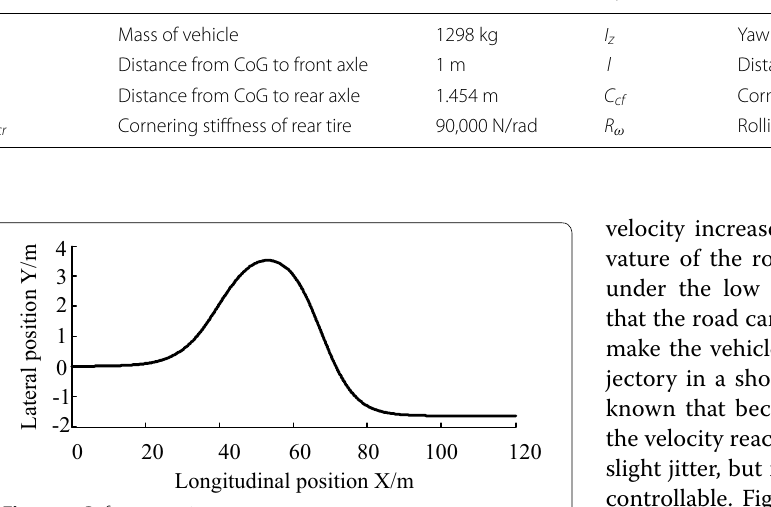
Table 2 Main parameters used in the simulation Symbol